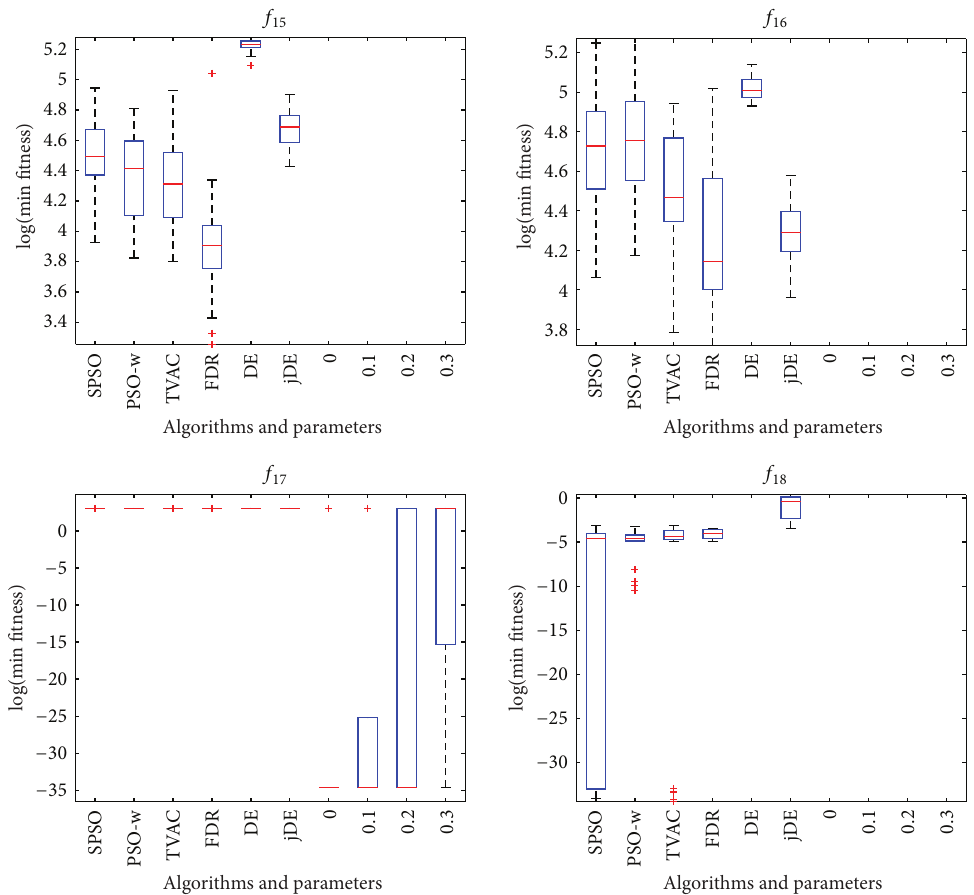
Figure 6: HPSO-DE with different balance parameters and other six algorithms on 𝑓 15 , 𝑓 16 , 𝑓 17 , and 𝑓 18 .